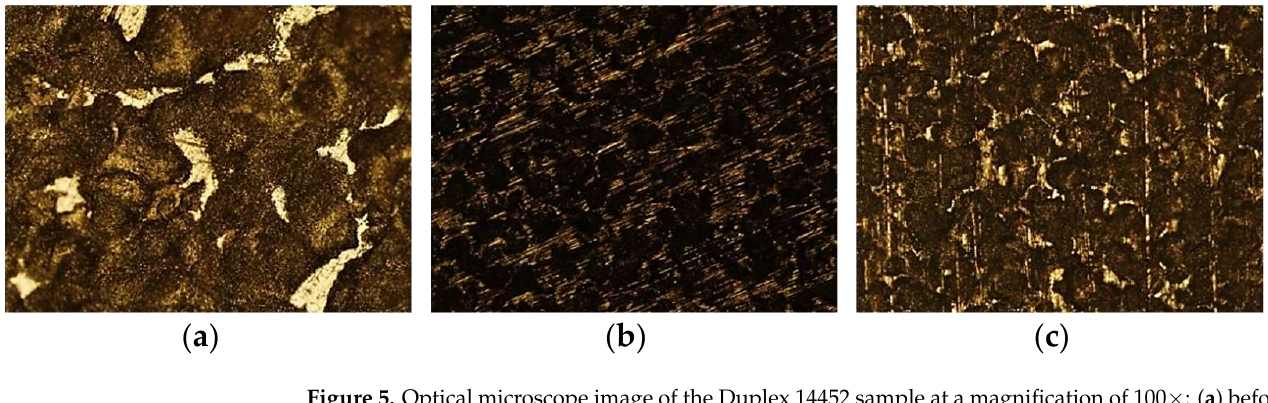
Figure 5. Optical microscope image of the Duplex 14452 sample at a magnification of 100×: ( a ) before immersion, ( b ) after three weeks, ( c ) after three months.